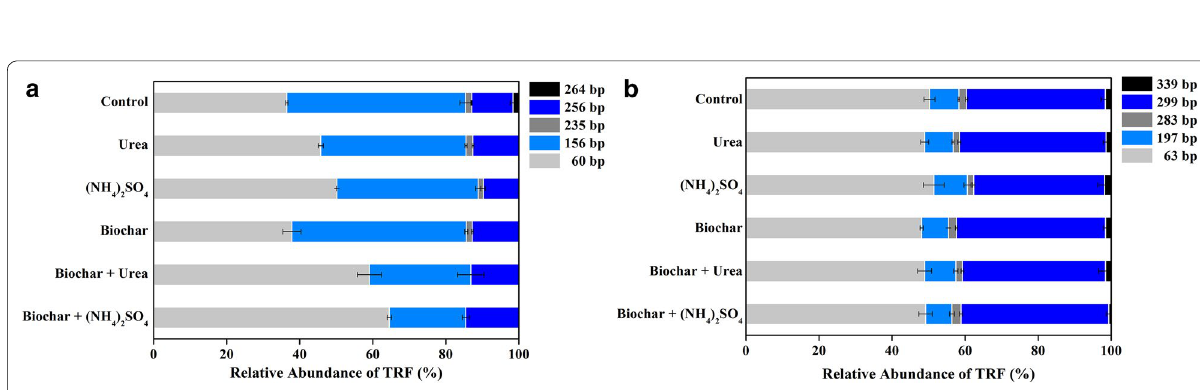
Table 1 The Shannon index (H) and Simpson index (D) of AOB and AOA community structure diversity